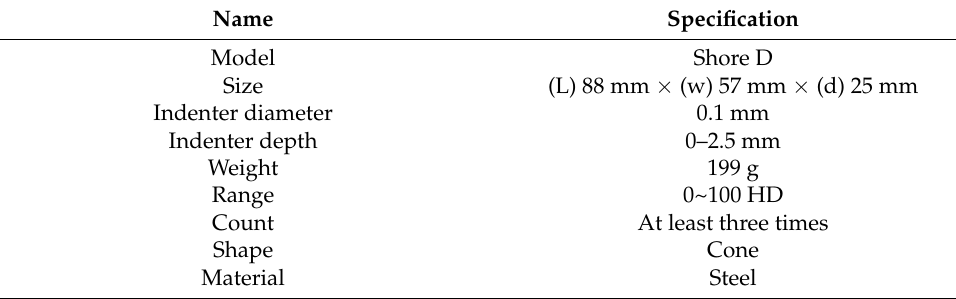
Table 6. The specifications of the Shore